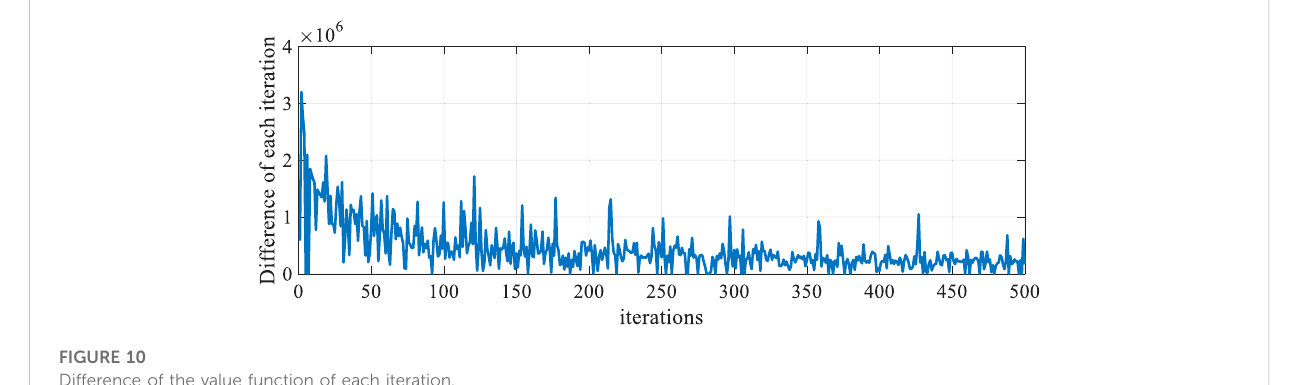
FIGURE 10 Difference of the value function of each